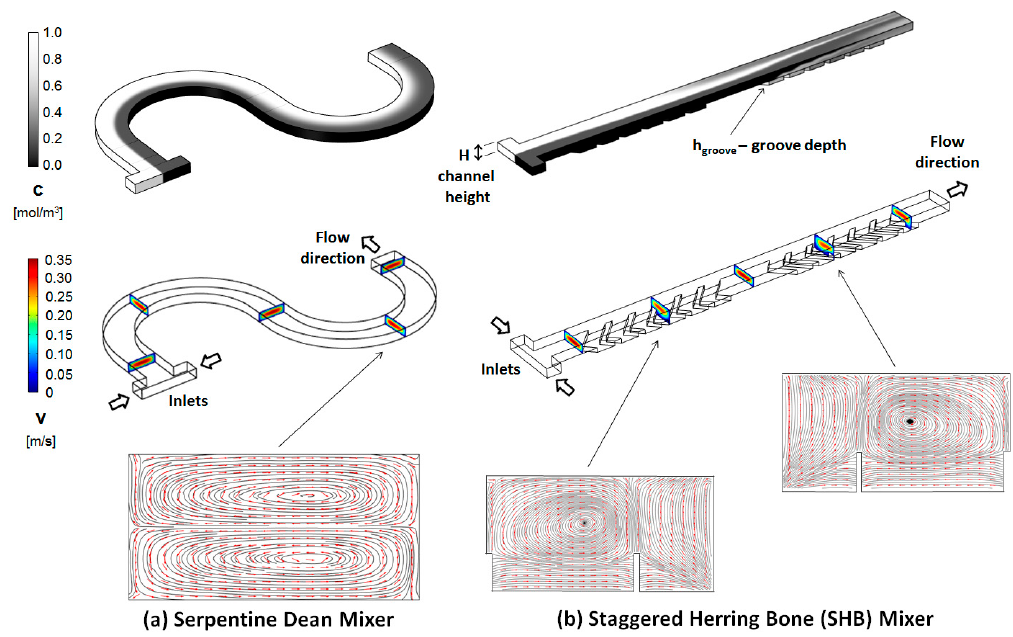
Figure 1. ( a ) Serpentine and ( b ) staggered herring bone (SHB) micromixer geometrical topologies. ( Top ) Concentration distribution along the channel, with the fluids to be mixed introduced through two opposite inlets; ( middle ) Geometry of the channels and the velocity field cross-sections at different positions along the channel; ( bottom ) Transversal streamline/arrow plots ( Re = 20 for both designs).